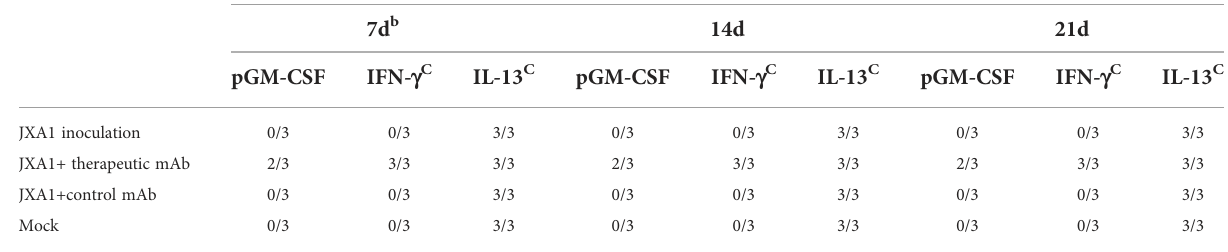
TABLE 3 Detection of cytokine from serum samples.